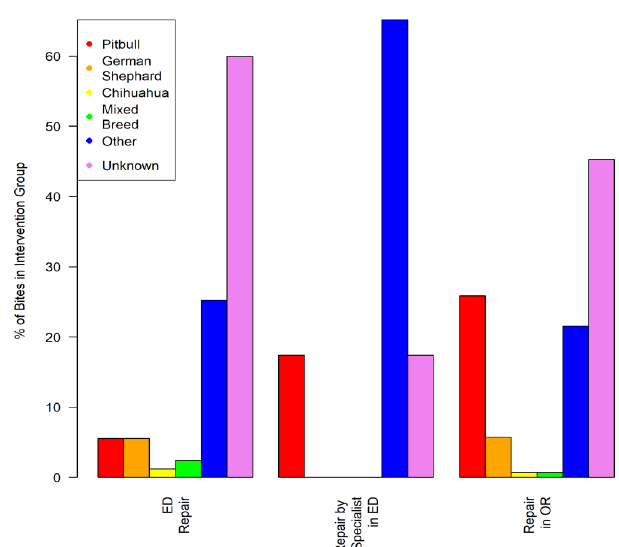
Figure 6. Level of intervention by breed of